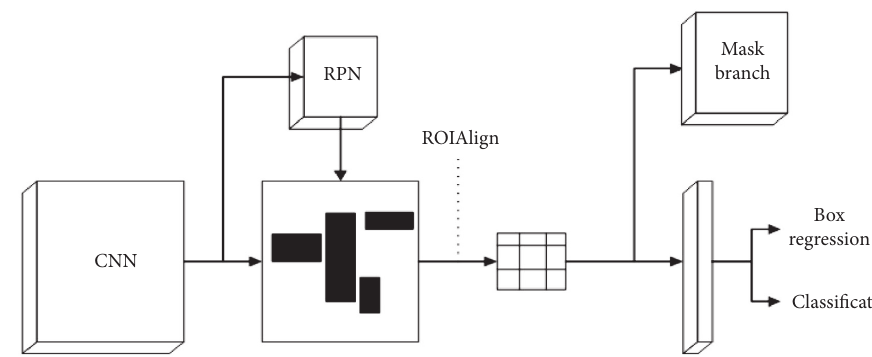
Figure 2: Mask R-CNN network structure.